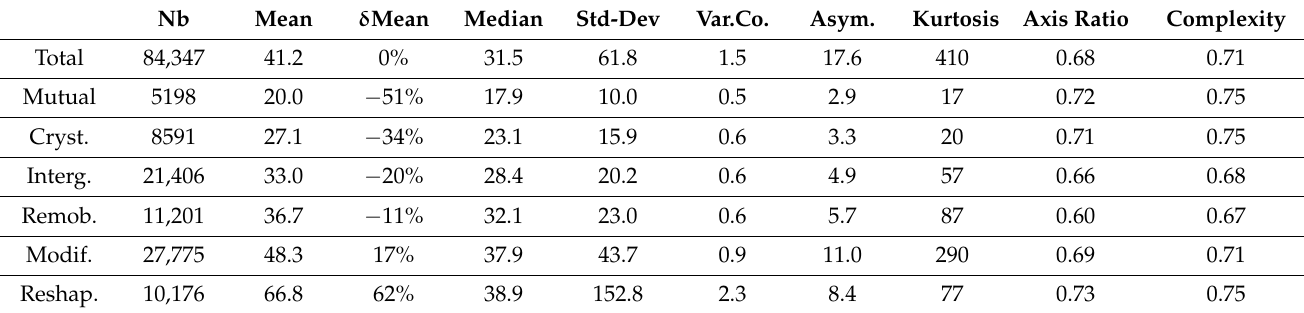
Table 3. Statistics of the size distribution of gold grains according to their shape. The variation in size ( δ mean) is the average size of a class, compared to the average size of the entire population. High asymmetry and Kurtosis are expected considering the log-normality of the distribution, but remain positive even when calculated on the logarithm of diameter. Axis ratio is the ratio of the width to length. Complexity is the ratio of the measured surface ( π ECD 2 /4) to the surface of the enclosing rectangle (L × l).